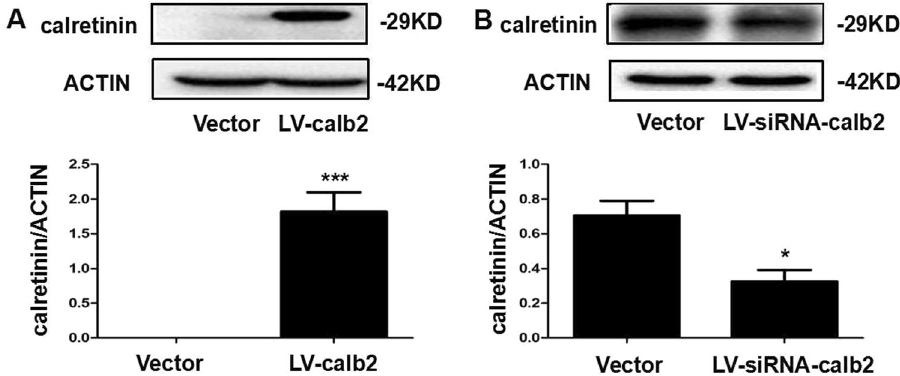
Figure 1. The expression of calretinin in the MLTC-1 and R2C cells infected with LV-calb2 and LV-siRNA- calb2. ( A ) The expression of calretinin in the MLTC-1 cells infected with LV-calb2. Compared with the vector infection group, the LV-calb2 infection cells had significantly higher expression of calretinin ( p < 0.001). ( B ) The expression of calretinin in the R2C cells infected with LV-siRNA-calb2. Compared with the vector infection group, the LV-siRNA-calb2 infection cells had significantly lower expression of calretinin ( p < 0.05). All experiments were independently repeated three times. * p < 0.05; *** p < 0.001. The original blot images can be found in Supplmental Fig.